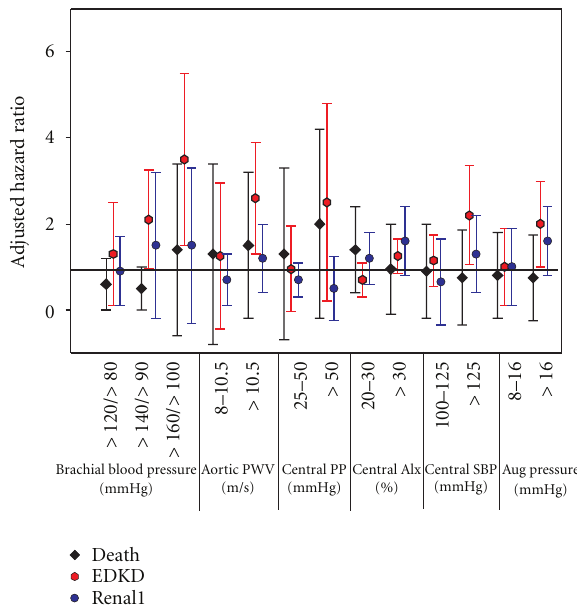
Figure 6: Referent groups are < 120/ < 80 for brachial BP, < 8m/sec for aortic pulse wave velocity (PWV), < 25mmHg for central pulse pressure (PP), < 20% for central augmentation index (AIx), < 100 for central systolic blood pressure (SBP), and < 8mmHg for the augmented (Aug) central pressure wave. Endpoints were death (black diamond), end-stage kidney disease (ESKD, red hexagon) and doubling of serum creatinine or ESKD or death (blue